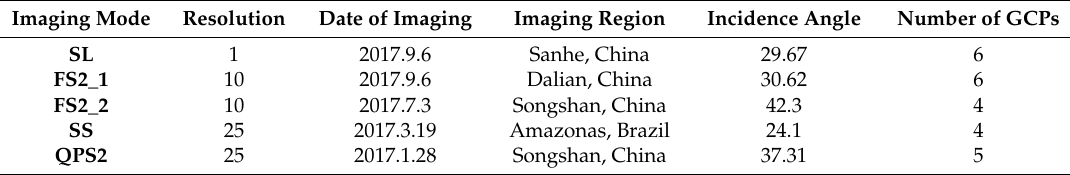
Table 2. GaoFen-3 (GF-3) synthetic aperture radar (SAR) images with information regarding the test